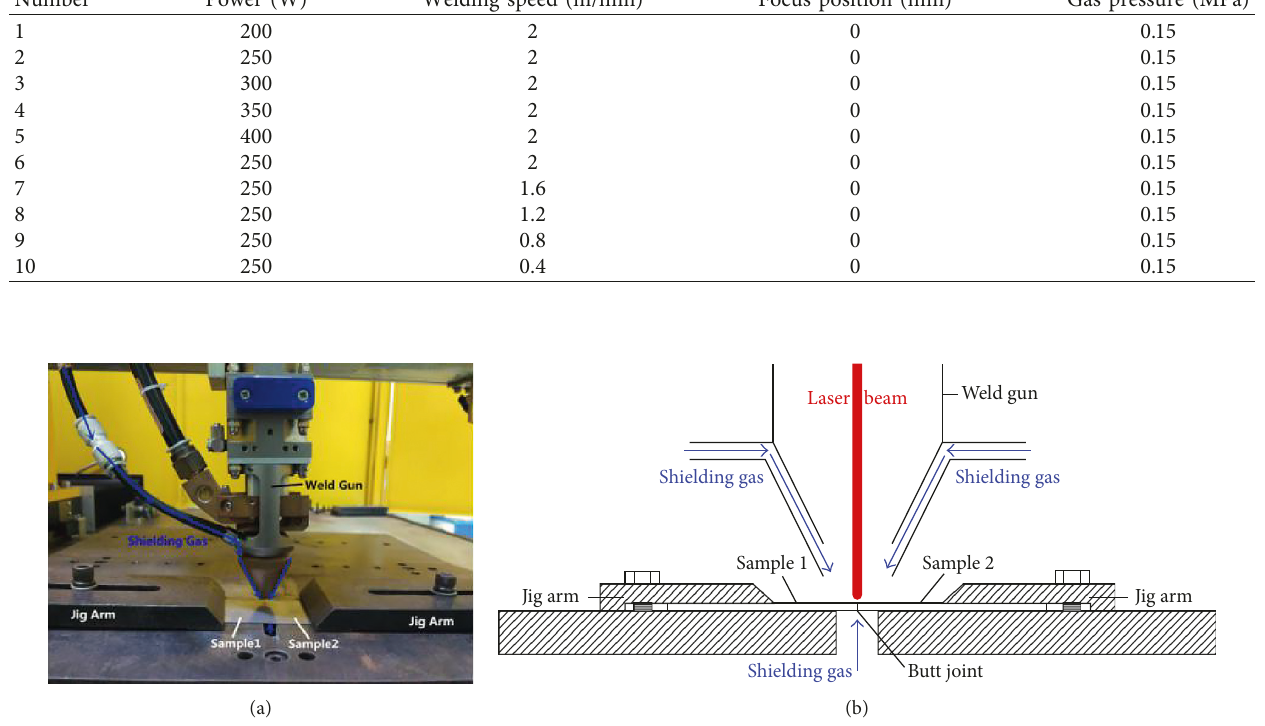
Figure 1: (a) The way of fixing the plates; (b) schematic diagram.